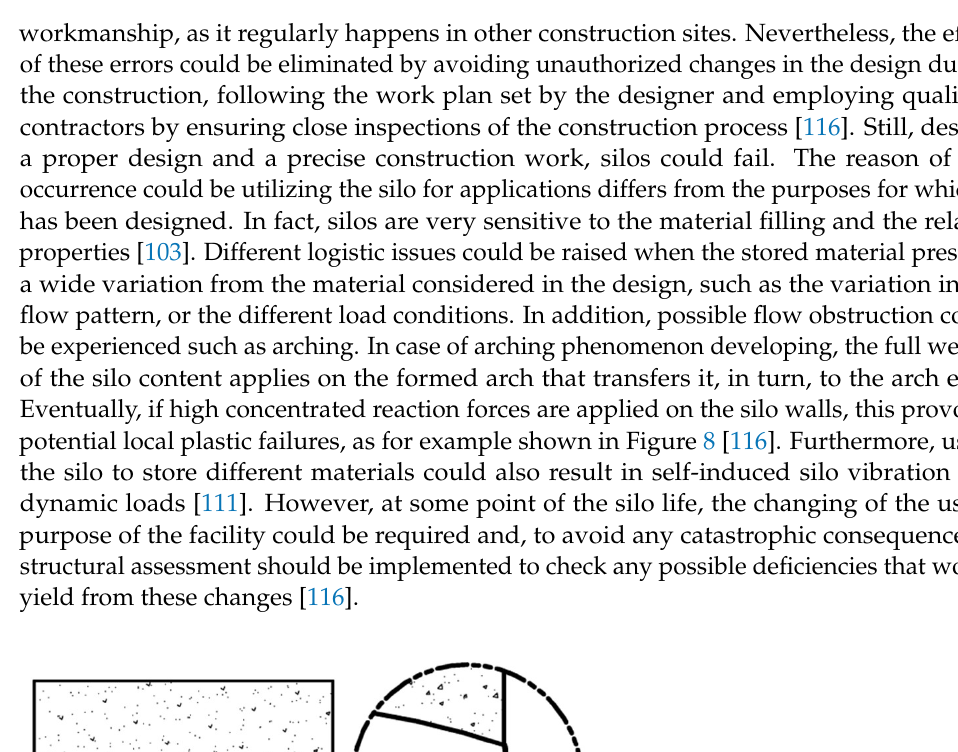
Figure 7. Extreme damage in grain silo caused by asymmetric flow pattern. Source: [29].